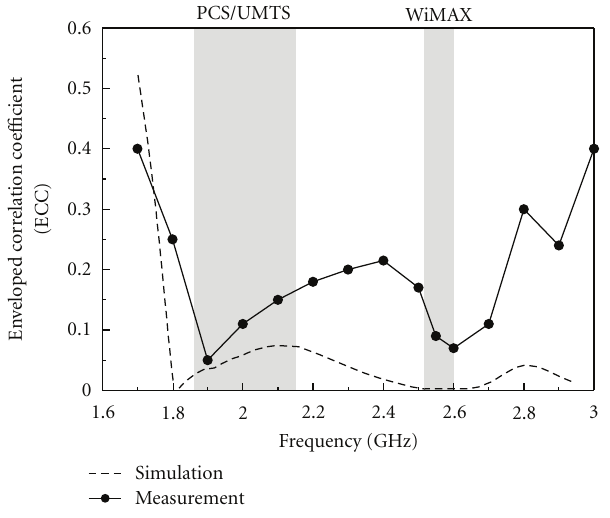
Figure 7: Simulated and measured ECC.